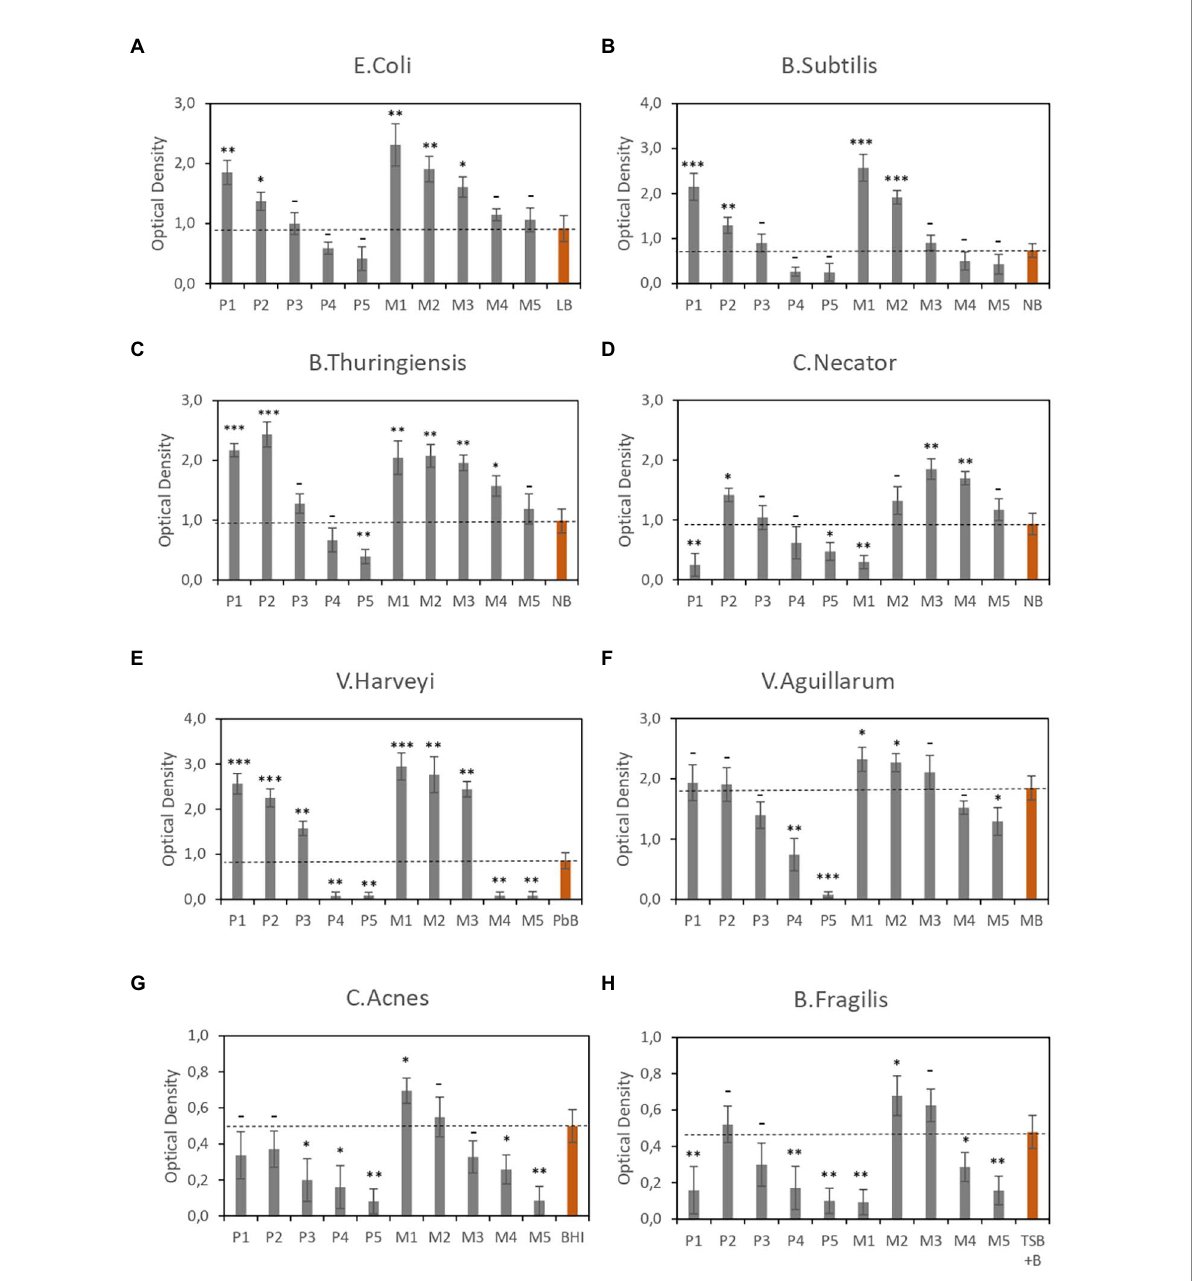
FIGURE 1 Optical density of bacterial cultures in different CE-based media. (A–F) Aerobic cultures. (G,H) Anaerobic cultures. Data are the average of three independent experiments. Red bars correspond to the reference media. Error bars are the standard deviation of three independent experiments. p -values * p < 0.05, ** p < 0.01, *** p < 0.001, and – p ≥